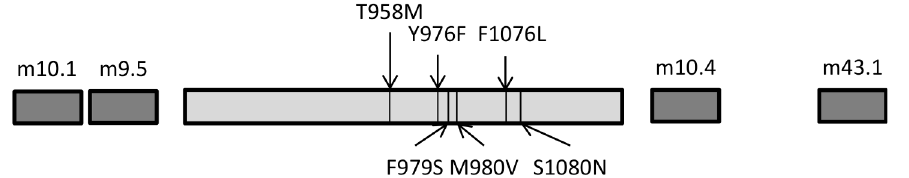
Fig 1. The Pvmdr1 gene and the relative position of the chosen MS. The identified SNPs within Pvmdr1 and the two chosen MS downstream of the Pvmdr1 gene; m9.5 (9,489 bp downstream of Pvmdr1 ), m10.1 (10,120 bp downstream) and the two upstream MS: m10.4 (10,420 upstream) and m43.1 (43,168 bp upstream) are